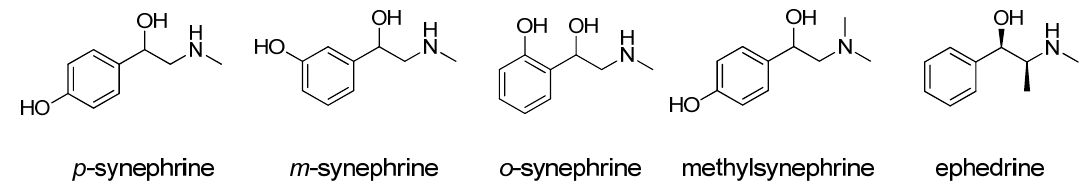
Figure 1. Structures of para -, meta - and ortho -synephrine, methyl-synephrine and ephedrine.